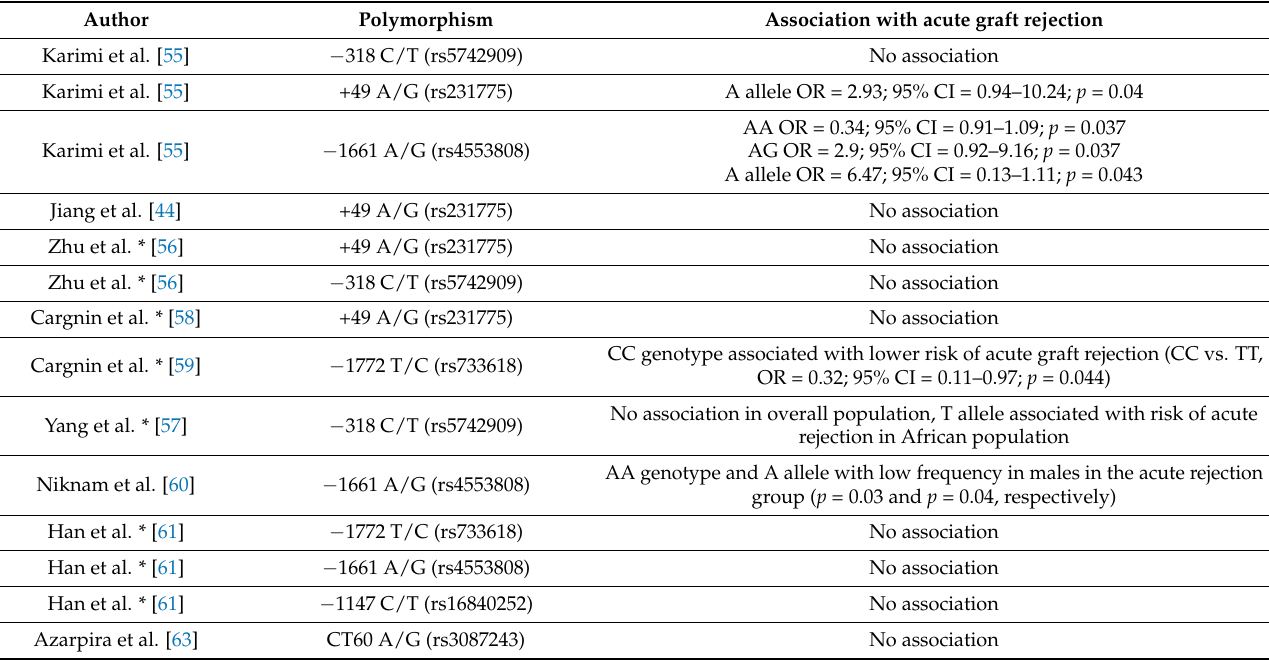
Table 1. The association between common recipient SNPs within the CTLA-4 gene and acute graft rejection in solid organ